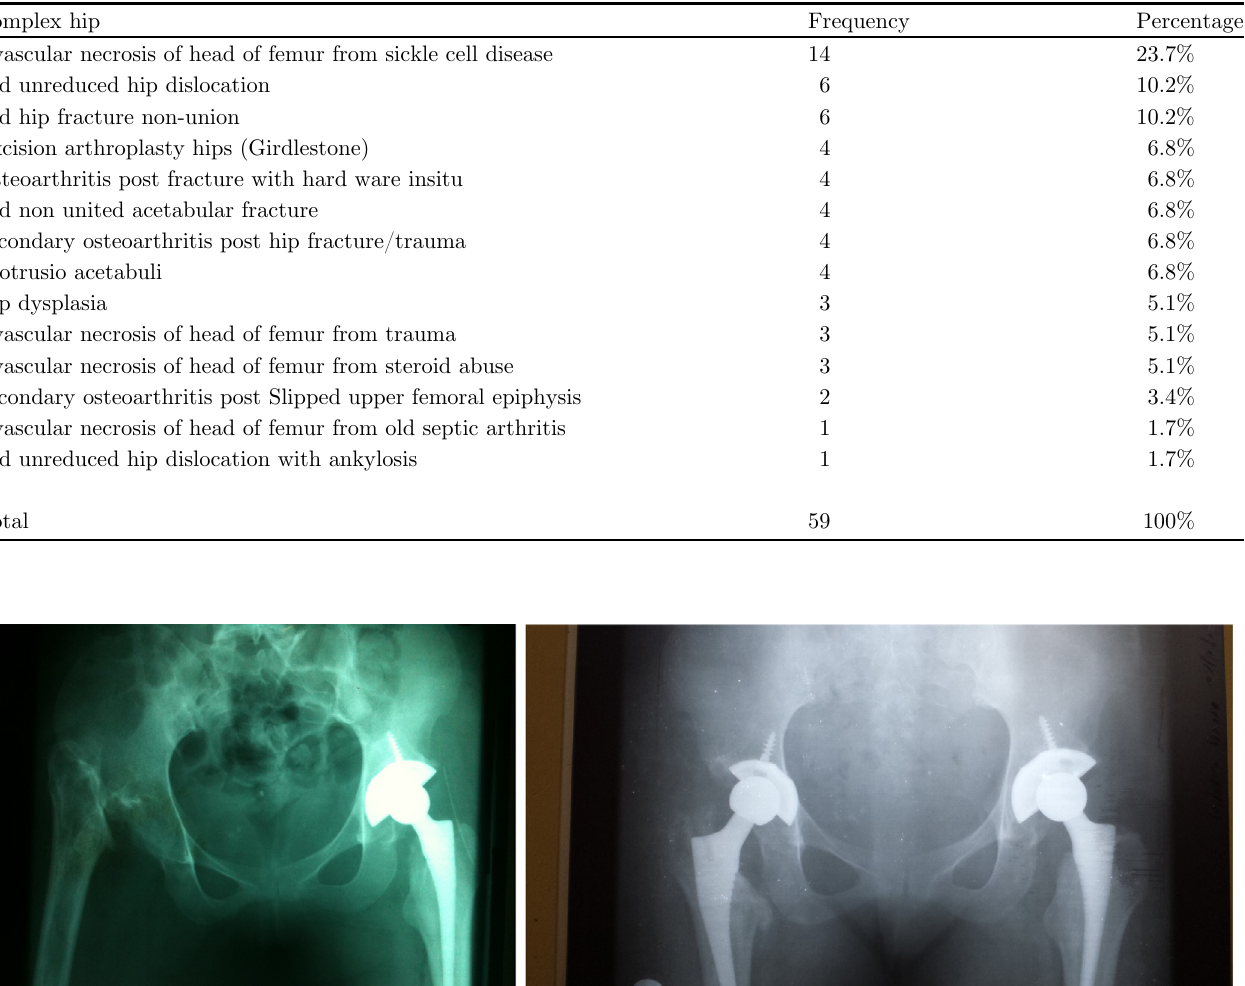
Table 1. Complex primary hip cases.